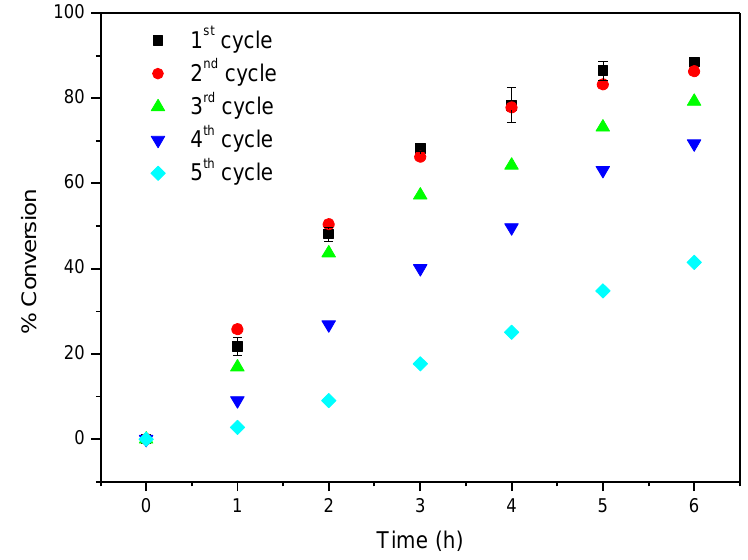
Figure 14. Oxidation of cyclooctene using CAT-4-MR as catalyst and TBHP as oxidant with additions of 0.5 eq. every 15 min.